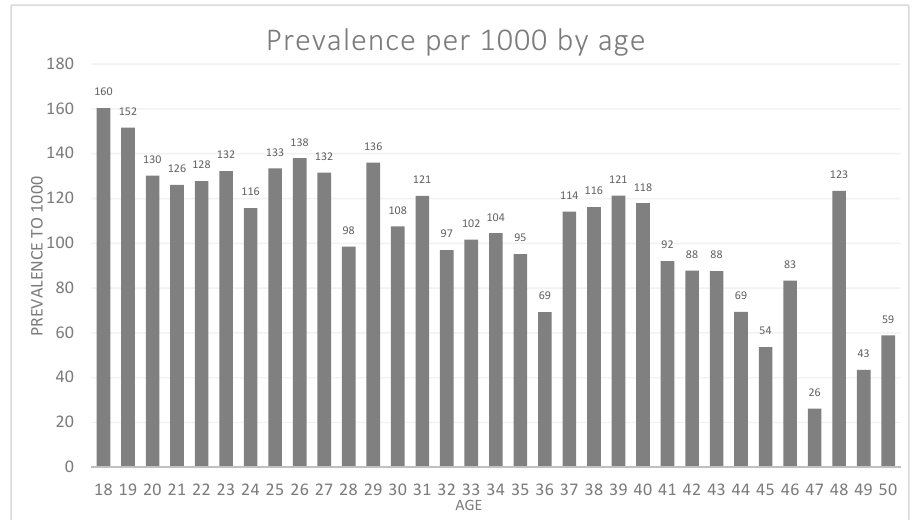
Figure 1. Number of SOS teeth per 1000 by age among the study population. Table 3. Mean number of SOS teeth and the rate of SOS teeth per 1000 by age.